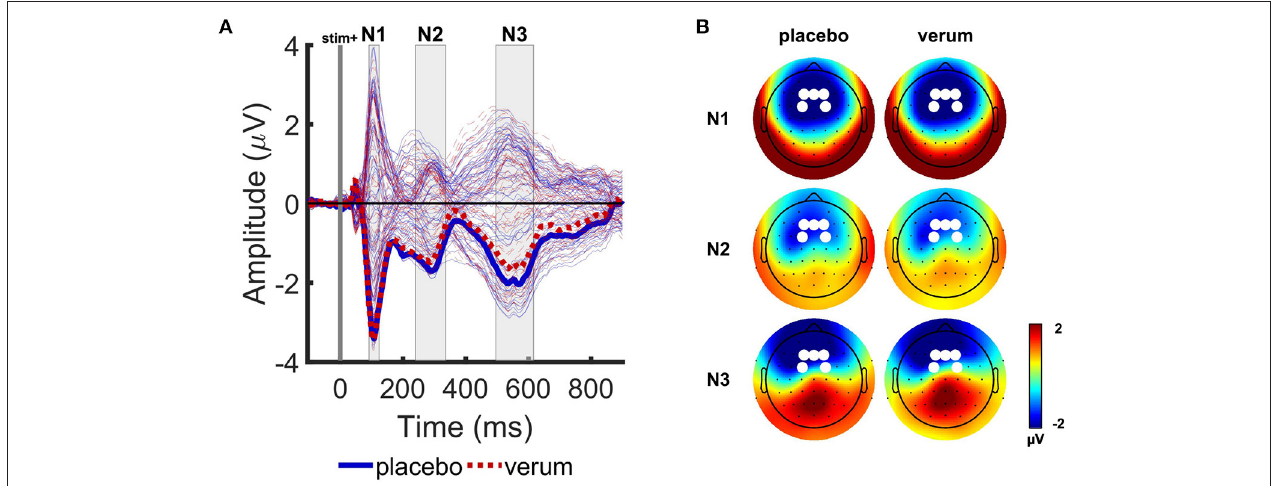
FIGURE 3 | Grand average event-related potentials (ERPs) of the Attention Modulation by Salience Task. (A) Grand average ERP responses averaged over 4 picture types and two tones (T1 and T2), for placebo (blue solid lines) and Nx4 (red dashed lines) conditions. Tone onset is indicated with vertical gray line. Electric field revealed three prominent peaks in N1 (92–124ms), N2 (240–336ms) and N3 (496–616ms) time intervals, indicated with gray rectangles. Thick lines indicate mean ERP response in the selected channel group. (B) Scalp electrical field potential distributions of N1, N2, and N3 components for the placebo and Nx4 conditions. White dots indicate channels that were used for further ERP component